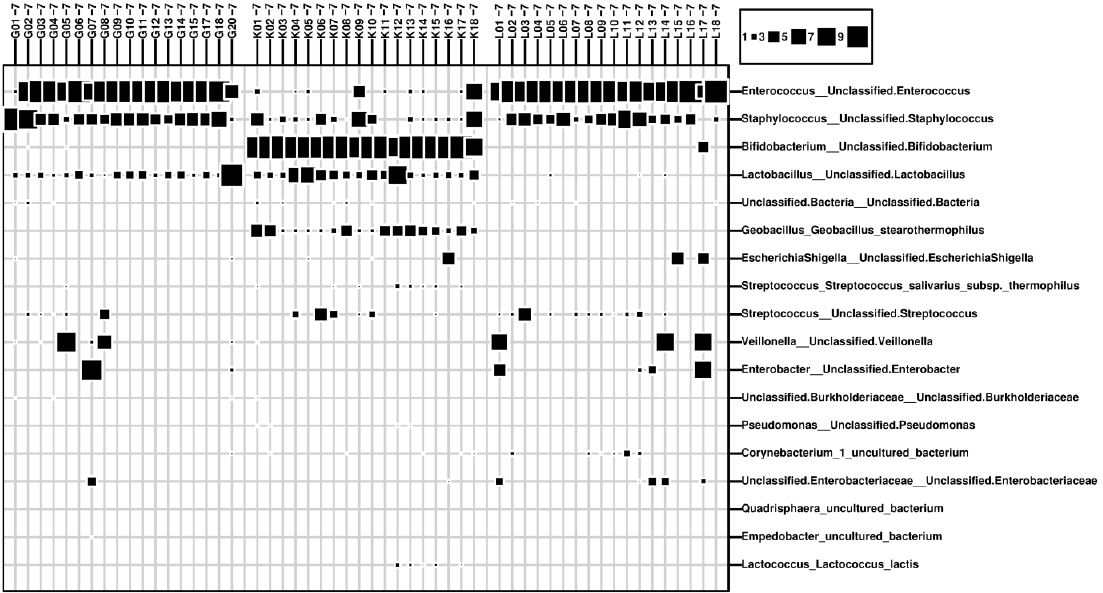
Figure 5. Bubble plot of samples from the three centers at t7 (BLG included), displaying the relative abundance of the 18 most abundant microbial taxa.